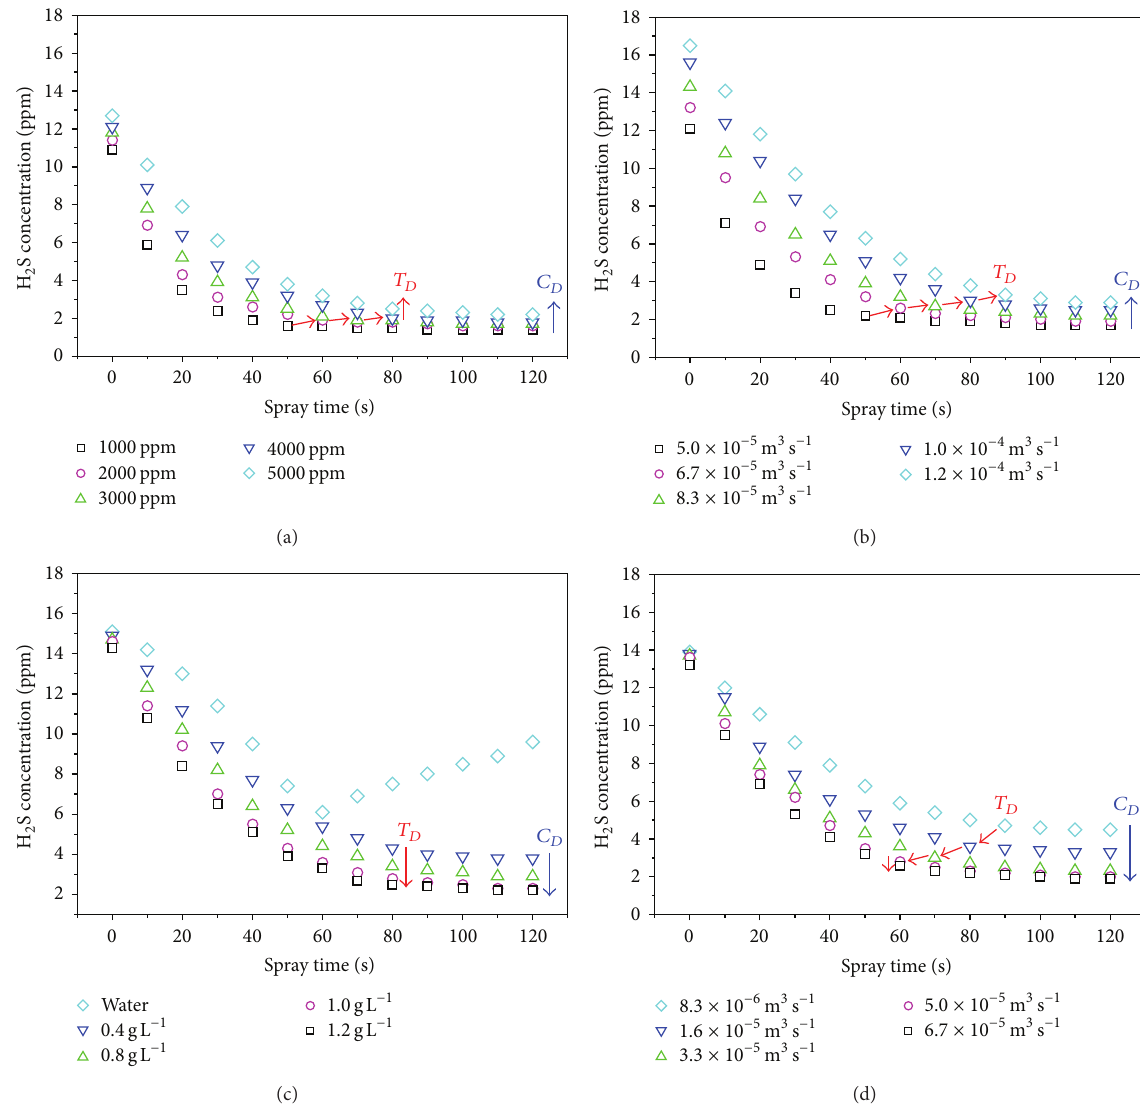
Figure 3: The influences of different parameters on the dilution capacity of water sprays: (a) H 2 S concentration; (b) gas release rates; (c) Na 2 CO 3 concentrations; (d) water flow